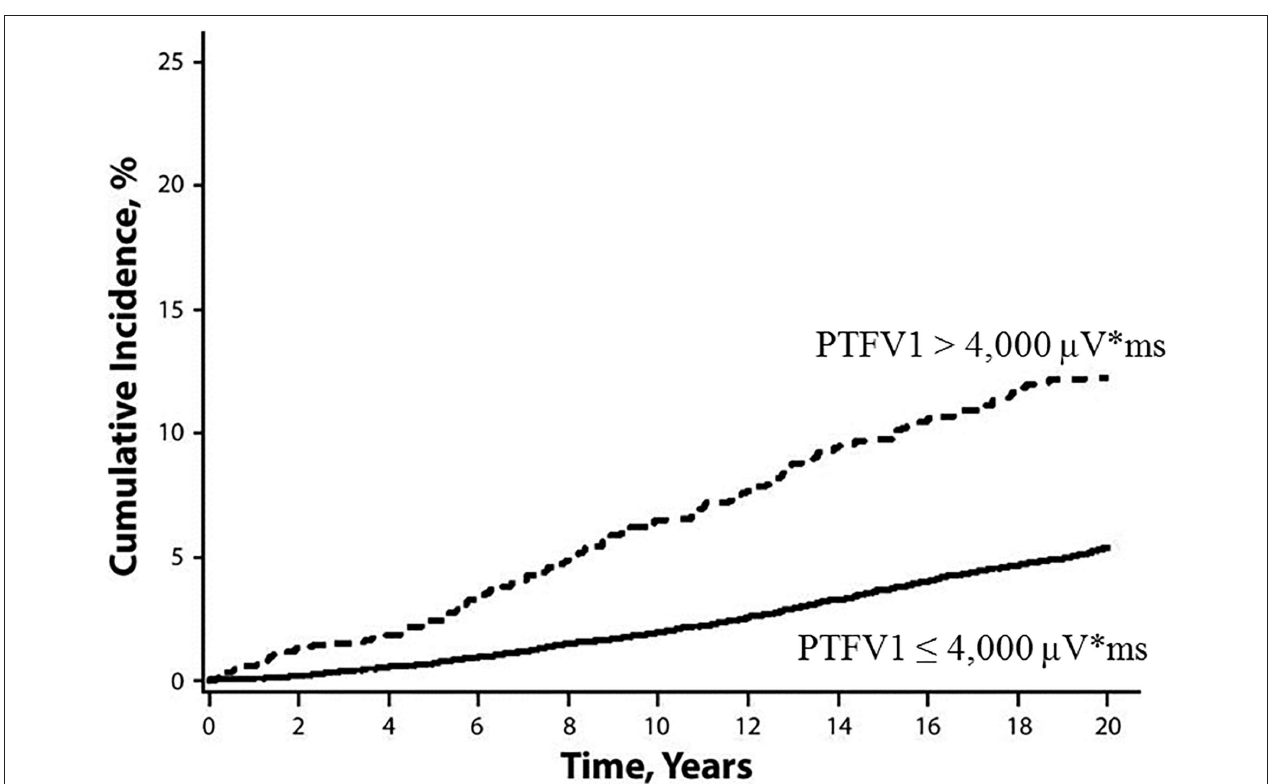
FIGURE 3 | Cumulative incidence of ischemic stroke, stratified by baseline PTFV1 (15). Ischemic stroke occurred more frequently in those with abnormal PTFV1 ( > 4,000 µ V* ms) than in those without (log-rank test p < 0.001). PTFV1, P -wave terminal force in lead